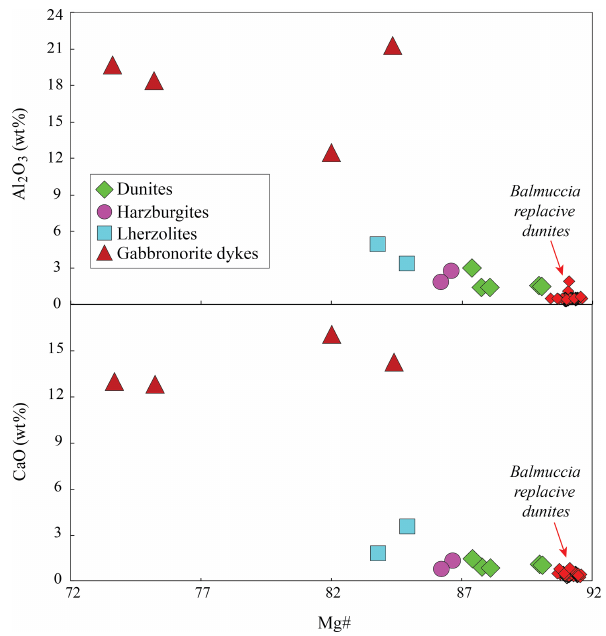
Figure 6. Diagrams showing the whole-rock chemical composi- tions of the selected samples from the Rocca d’Argimonia se- quence. Al 2 O 3 and CaO, calculated on anhydrous basis, versus Mg# [molarMg /( Mg + Fe 2 + tot ) × 100]. The compositions of mantle replacive dunites of the Balmuccia peridotite massif (Mazzucchelli et al., 2009) are reported for comparative purposes.